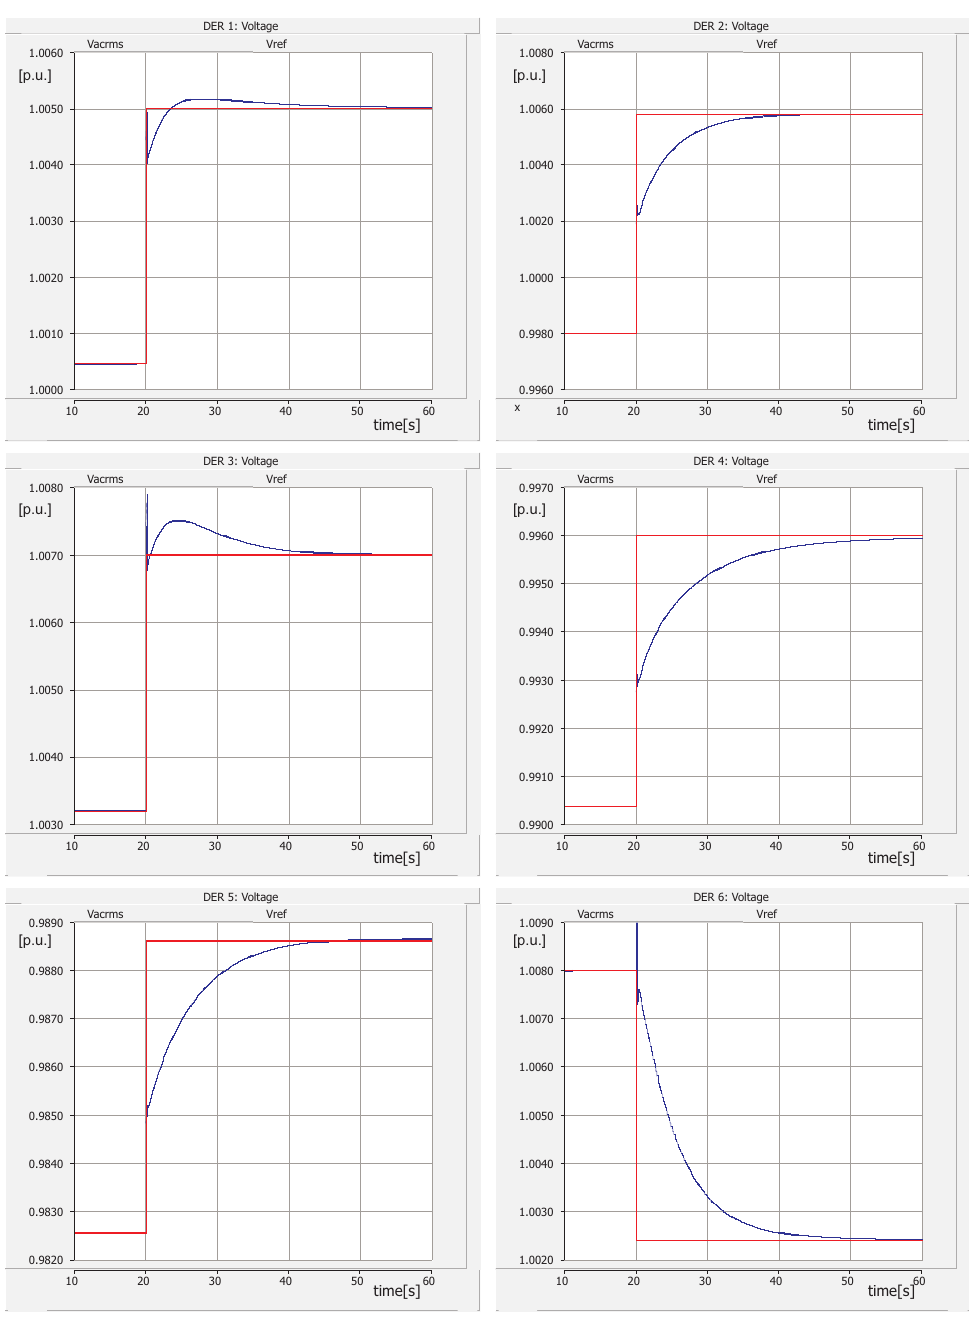
Figure 3. Time evolutions of the nodal voltages for the six DERs in response to a step variation of the voltage